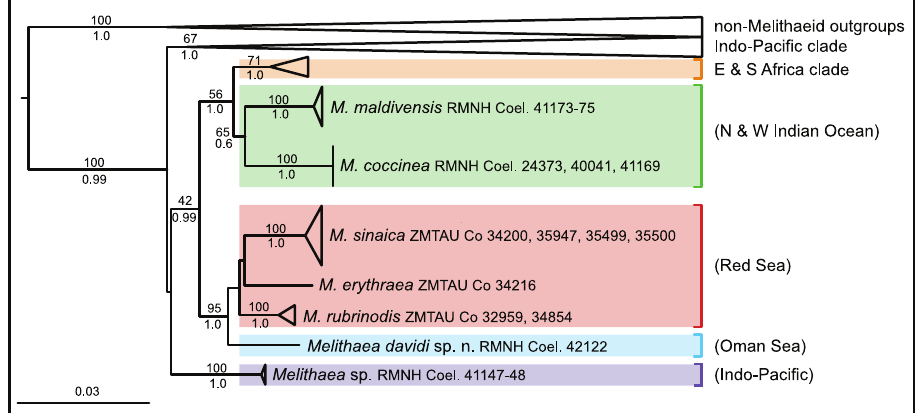
Figure 2. Maximum likelihood phylogeny of family Melithaeidae based on concatenated nucleotide se- quences for mtMutS (486 nt) and 28S rDNA (670 nt) (sequence data for all but RMNH Coel. 42122 are from Reijnen et al. 2014). Well-supported clades of species from the Indo-Pacific, east and south Africa, and outgroup taxa ( Annella , Chironephthya , Euplexaura , Siphonogorgia , Solenocaulon ) have been collapsed to improve readability. Numbers above branches are maximum likelihood bootstrap percentages; numbers below branches are Bayesian posterior probabilities. Generic assignments follow the recommendations of Reijnen et al.